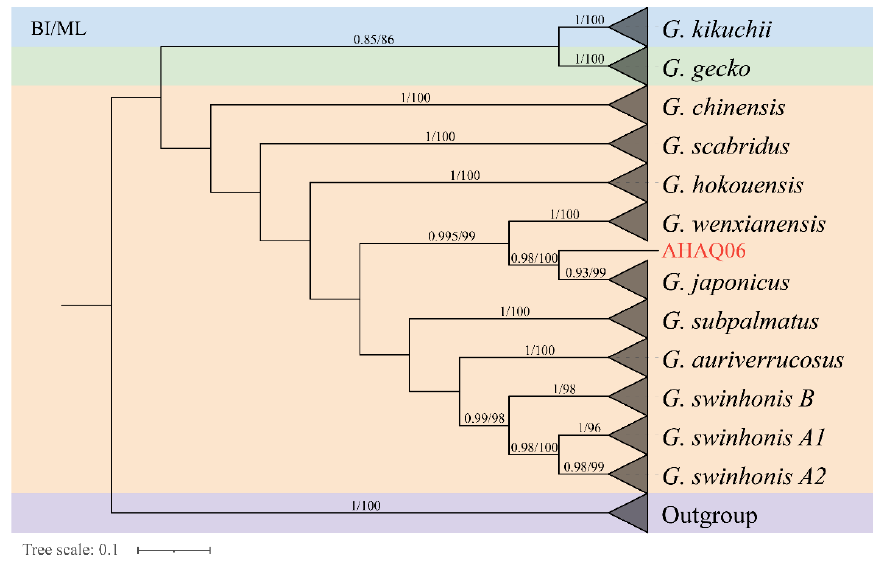
Figure 2. BI and ML tree constructed based on the COI gene sequence of 11 species and AHA06 of Gekko from China. Members of the G. japonicus group species are shown in orange, Gekko gecko group species are shown in green, Gekko monarchus group species are shown in blue and the purple part is the outgroup. The numbers above branches specify the posterior probability and bootstrap percentages (1000